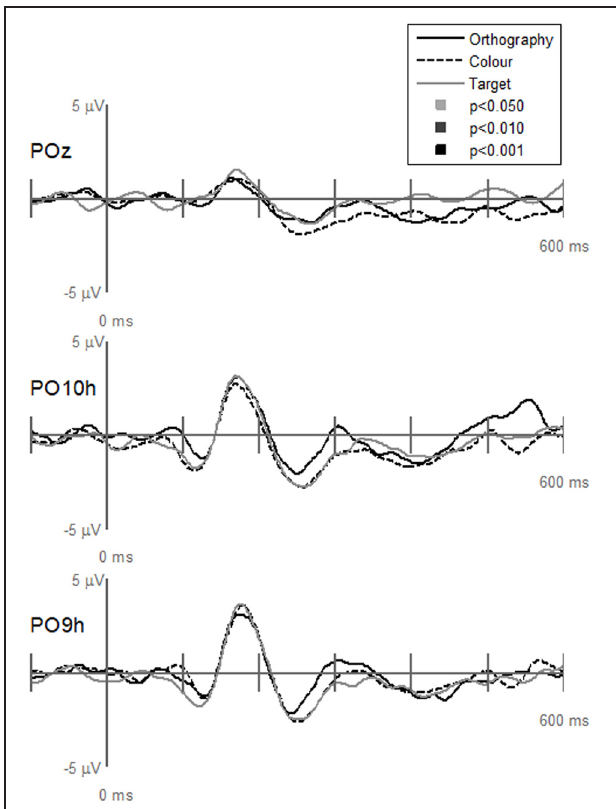
FIGURE 5 | Grand-mean evoked potentials for the Interaction of Task by Stimulus at electrodes POz, PO10h, and PO9h that showed significant Task or Stimulus effects (see Figures 3 and 4). Waveforms are plotted as the differences between letter and pseudoletters for each task (Orthography, Color, and Target). No statistical evidence of significant interactions were found at these electrodes or at any other scalp electrodes (data not shown) at p < 0 . 05, p < 0 . 01, and p < 0 .